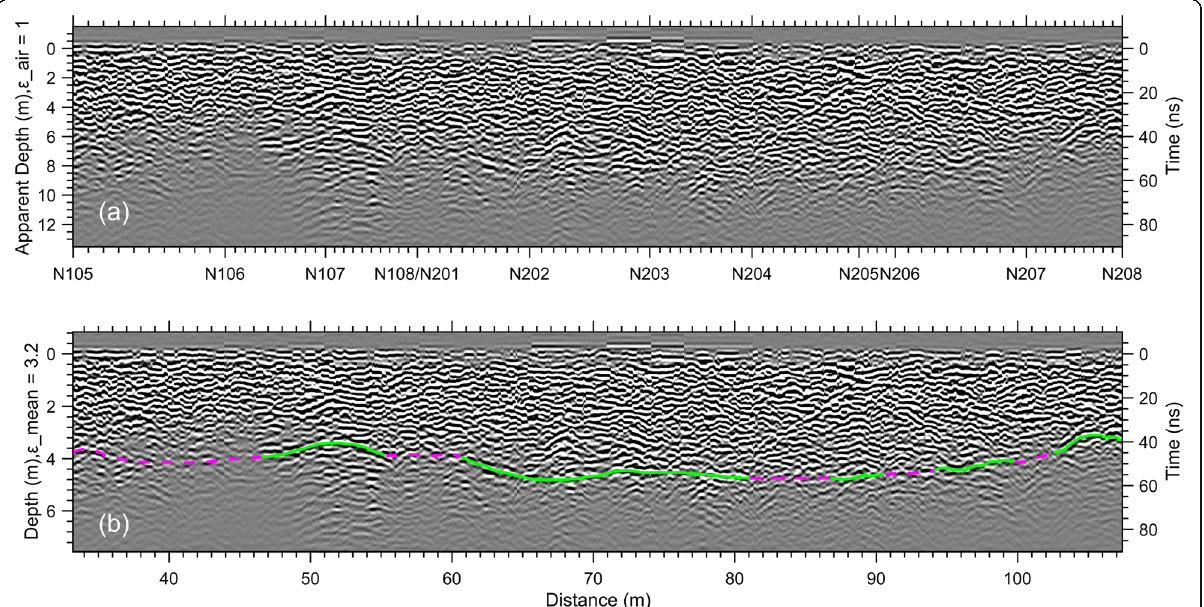
Fig. 2 Radargram obtained by the high-frequency LPR from the navigation points N105 to N208. The two-way travel time of the electromagnetic wave is shown in the right y -axis. a The final-processed radargram. The left y -axis is the depth corresponding to an assumed dielectric constant of 1. b Interpretations of subsurface structure of the radargram. The solid green lines are uneven reflectors that are interpreted as the boundary between the ejecta deposits of Ziwei and deeper more competent materials (e.g., Xiao et al. 2015; Fa et al. 2015). The dashed pink lines mark the approximate boundary where the signal transition is not obvious. The distance values shown in the lower panel are from ~ 33.2 to 107.4 m that are the route lengths from the landing site. The left y -axis mark depths that correspond to an assumed dielectric constant of 3.2 (Fa et al.